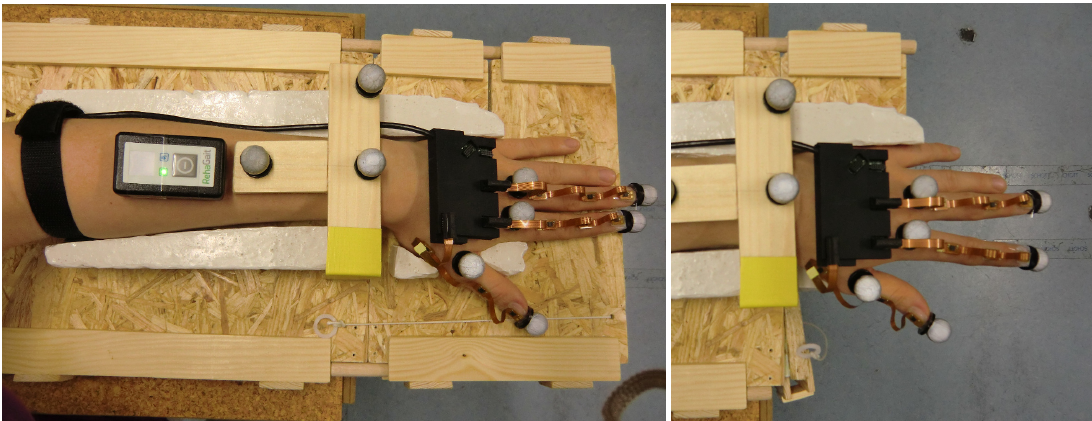
Figure 7. Measurement setup and positioning of the optical markers. The wooden fixture assures repeatability of the experiments and unrestricted finger motion without any translation of the forearm. The markers on top of the MCP joints are used for visualization purposes, and those on top of the fixture are used for coordinate transformation between the inertial system and the optical